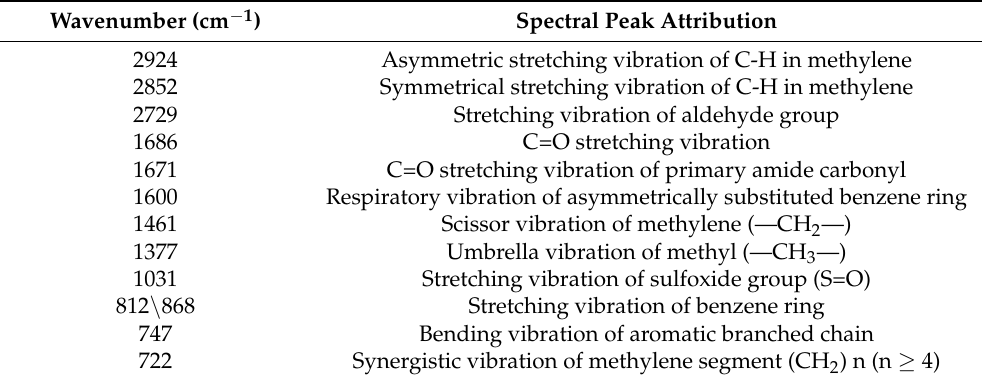
Table 4. Infrared spectrum analysis of